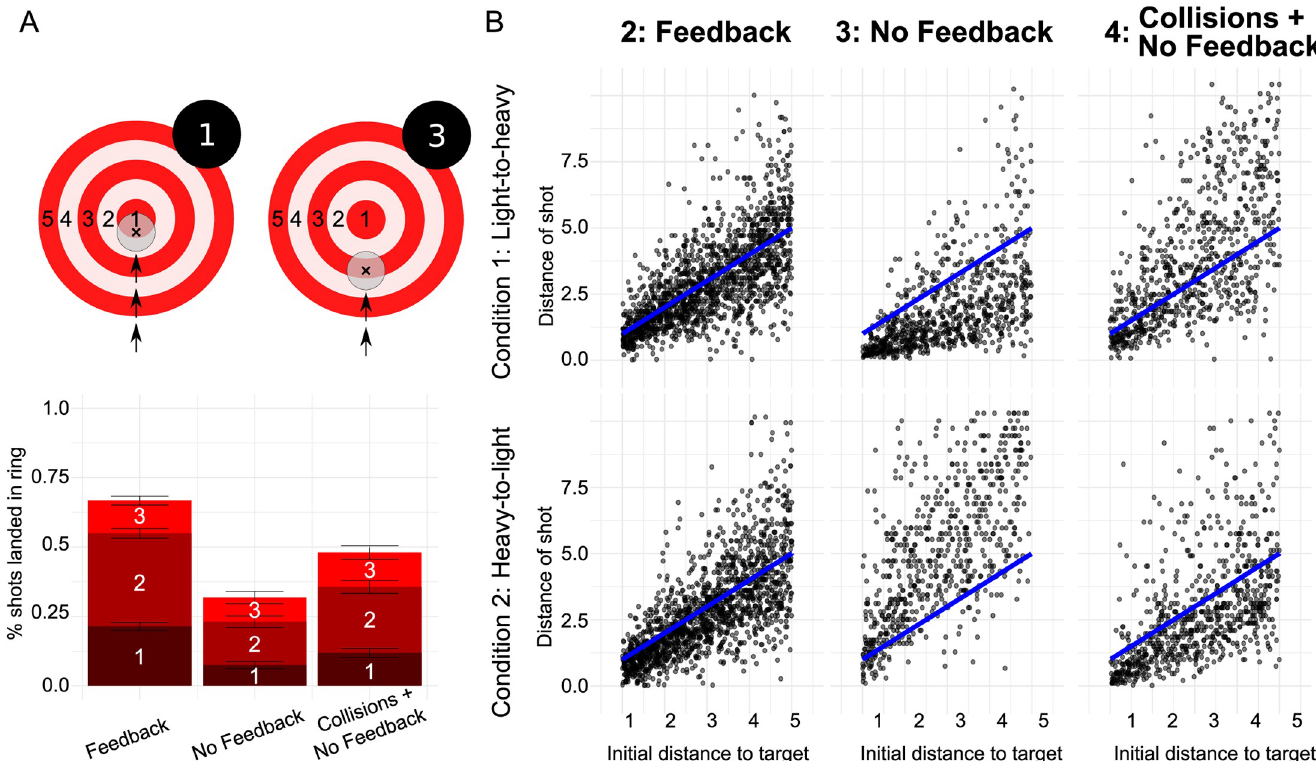
Fig 3. Task performance and pucks’ traveled distance for three phases of experiment. (A) Participants’ performance by experimental phase as quantified by pucks’ average absolute error in final position. The number of the ring at which the center of the puck stopped was used for coding performance, e.g. 1 and 3 in the shown cases. (B) Aggregated final positions of pucks versus initial distance of pucks to target. Phases of the experiment are separated by columns and conditions are separated by rows. The line of equality representing final positions prescribed by the Newtonian model with perfect knowledge of all parameters is shown in blue.